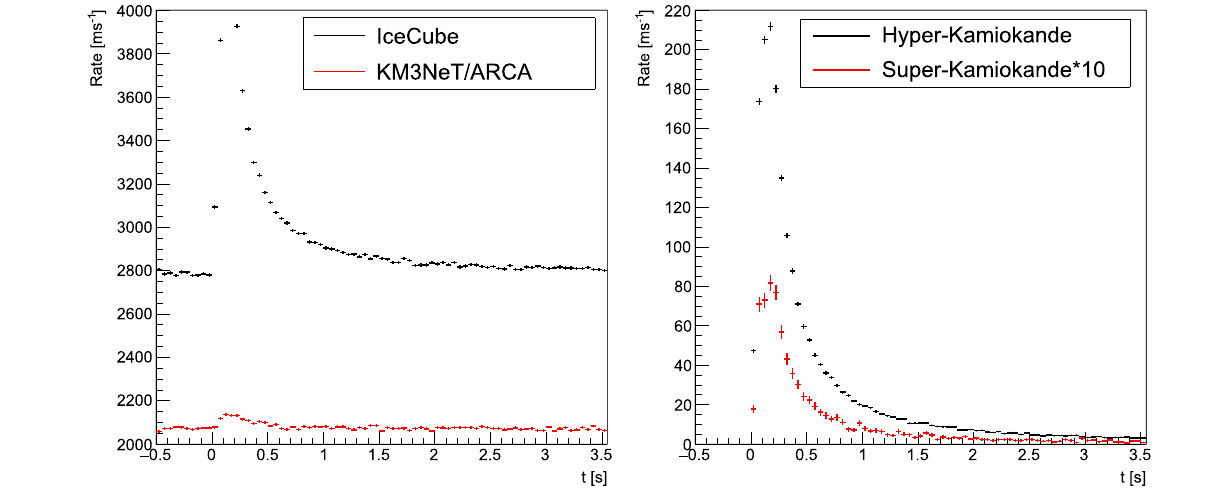
ten times for visual purposes (red) on the right. Error bars for each bin correspond to the original number of events in each bin scaled accord-